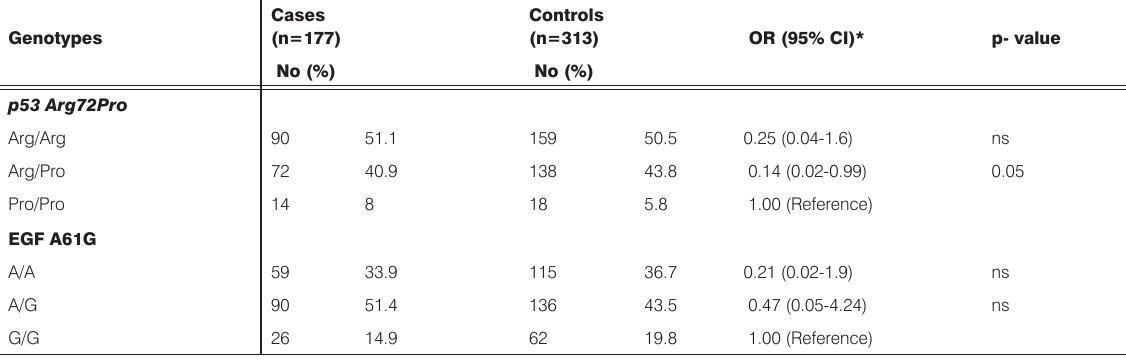
Table 3. Frequency distribution of EGF A61G or p53 Arg72Pro polymorphism between cases and controls and its association with risk of colo- rectal